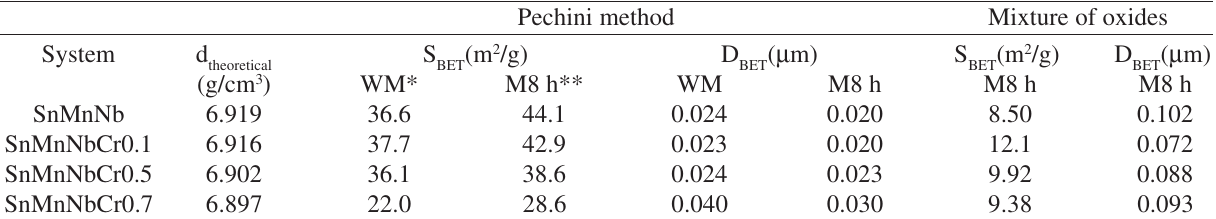
Table 2. Characterization of powders obtained by Pechini method and mixture of oxides, before and after milling: theoretical density, BET surface area and mean particle